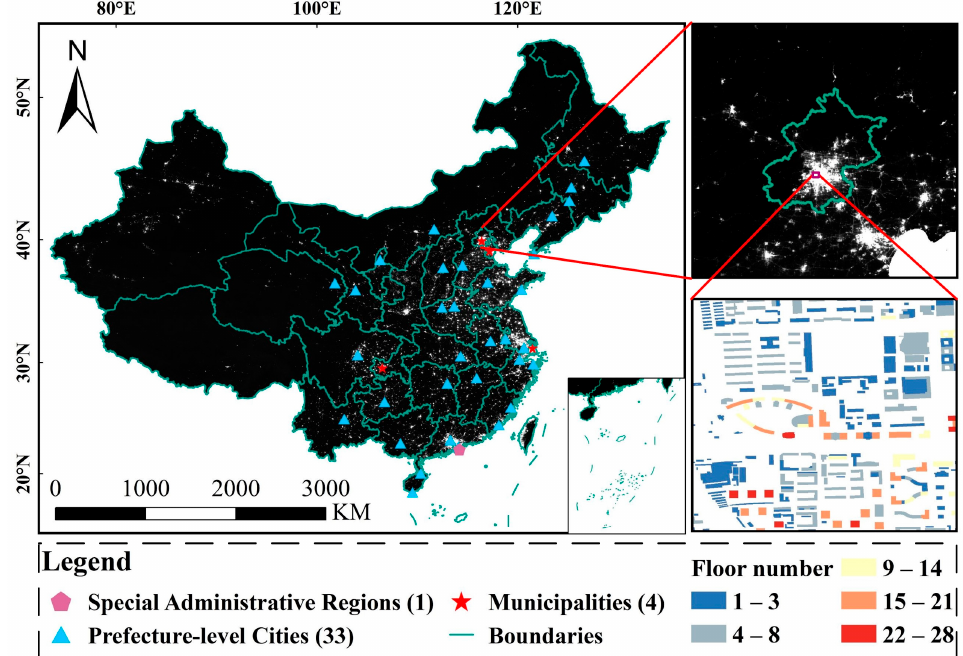
Figure 1. Spatial distribution of 38 cities in China. The base map is the nighttime light data derived from the Luojia-1 satellite in 2018. Figures on the right panel show the building footprint data with height information in Beijing